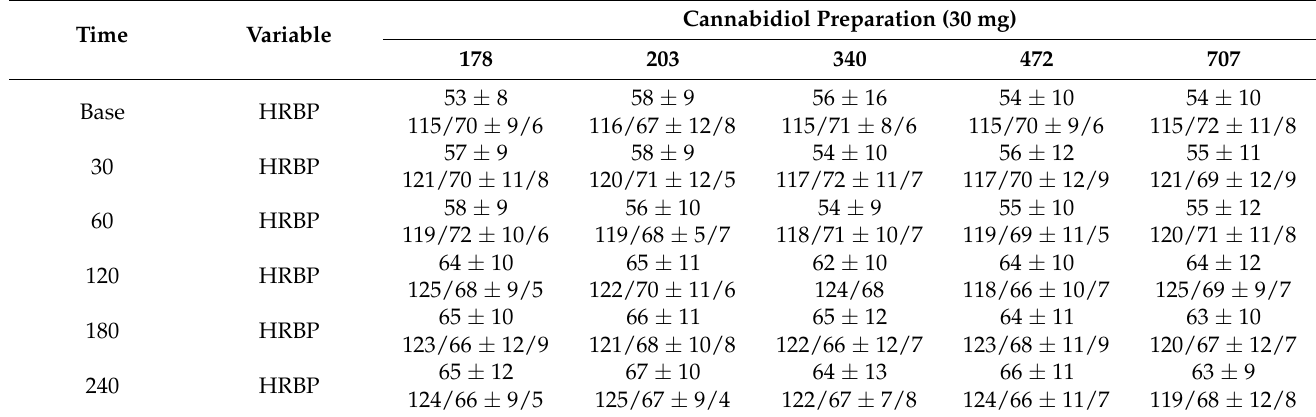
Table 5. Heart rate and blood pressure response to five different cannabidiol